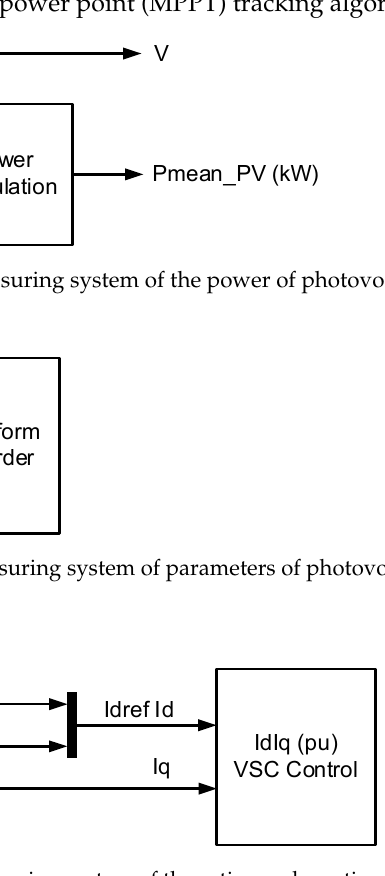
Figure 13. Diagram of the measuring system of the active and reactive component of the VSC current implemented in Matlab/Simulink.